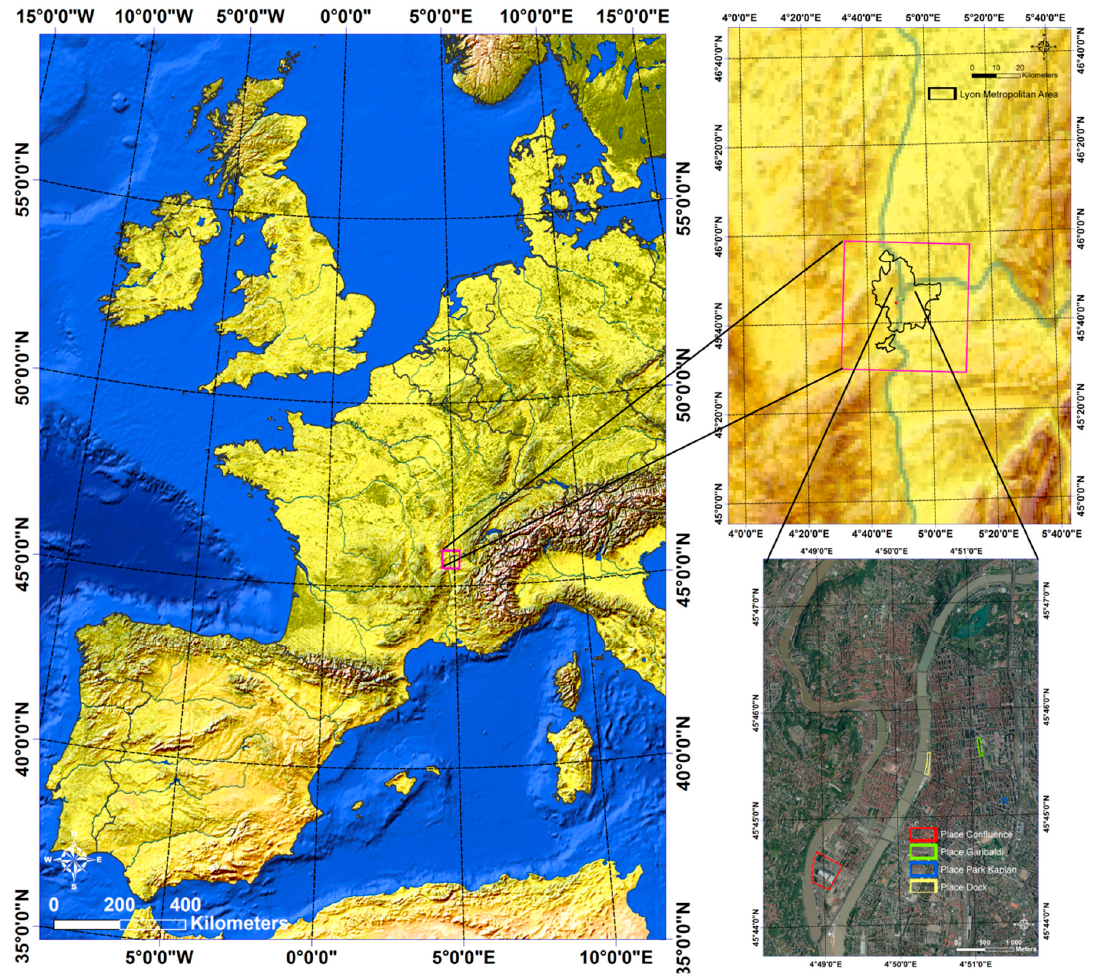
Figure 1. Location map of the Lyon metropolis. (source: left : Natural Earth; top-right : BD alti IGN, Euro Boundary Map; bottom-right : orthophotography data, Grand Lyon).